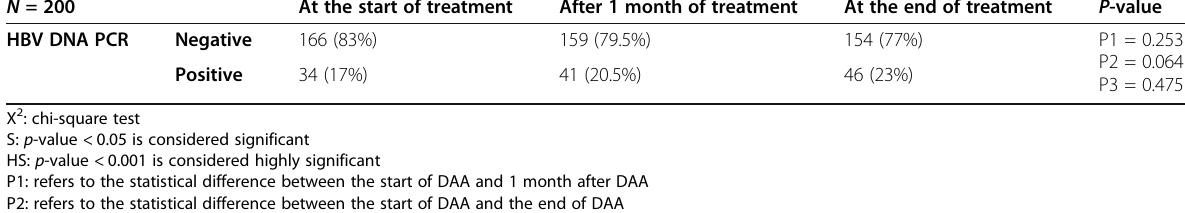
Table 2 Comparison between HBV DNA PCR results in the studied patients N = 200 At the start of